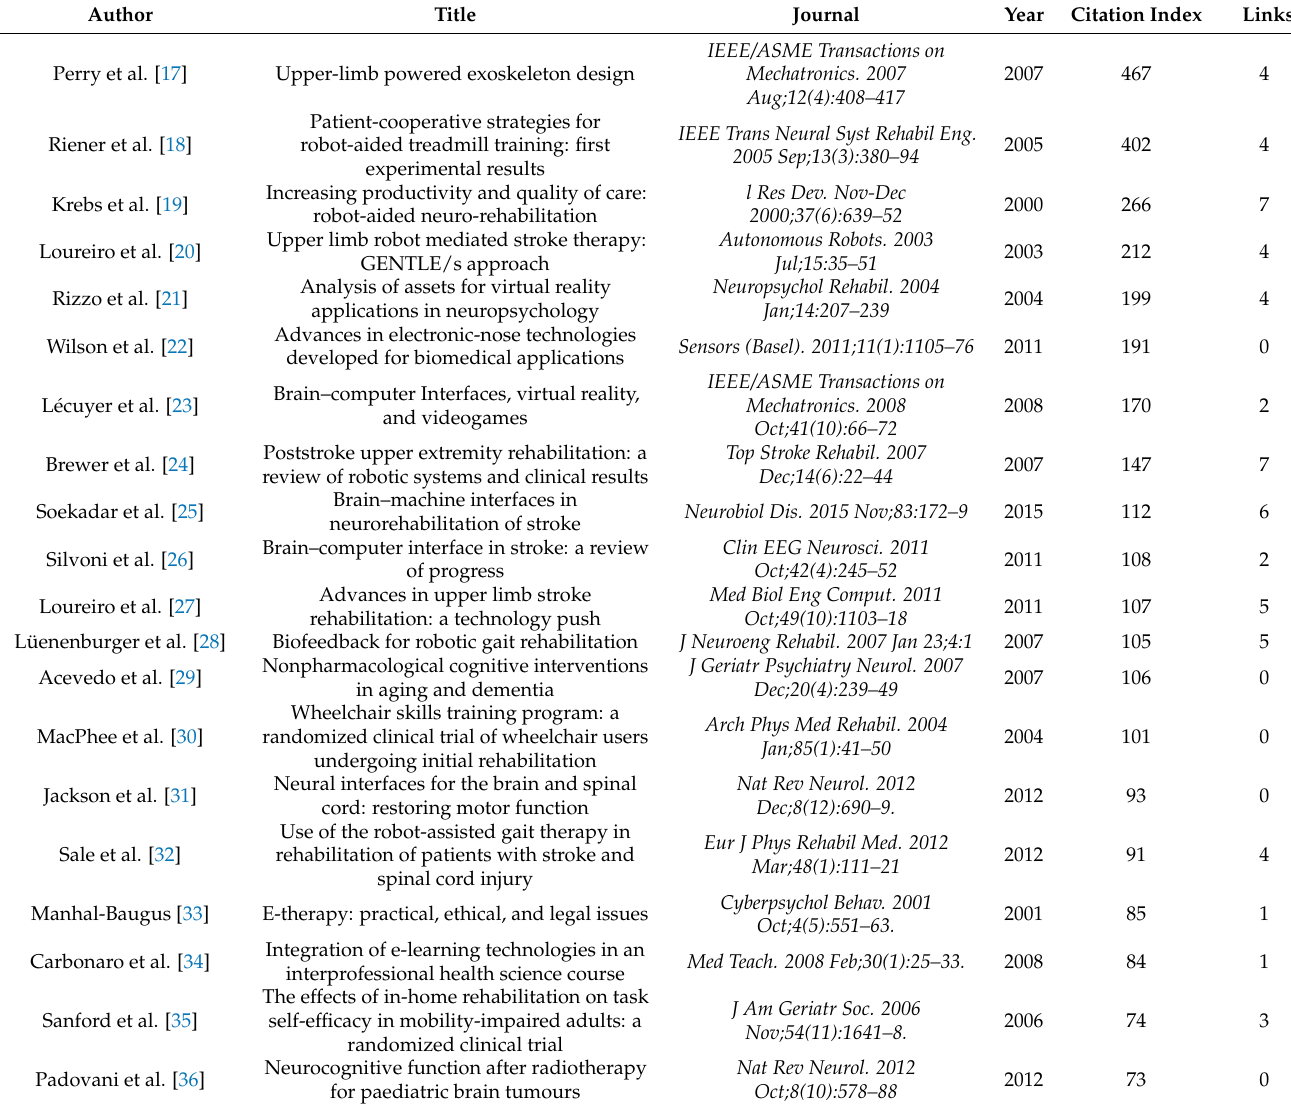
Table 4. Top 20 most cited papers.